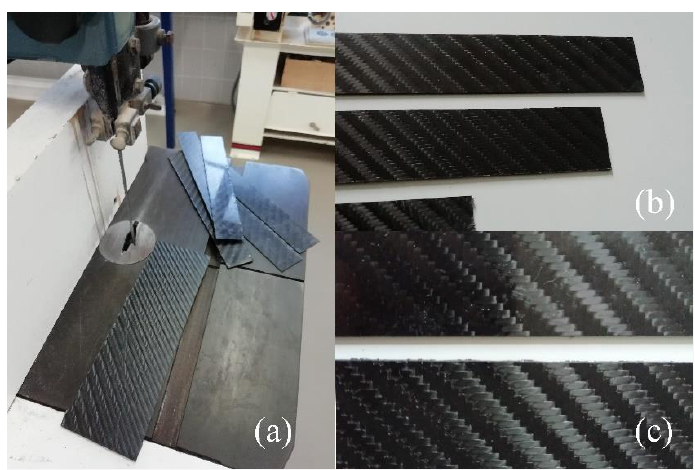
Figure 4. Manufacturing process of CFRE specimens: ( a ) cutting of 30 × 200 mm specimens; ( b ) finished specimens; and ( c ) detailed visual comparison of the surface of autoclave and VBO top surfaces.